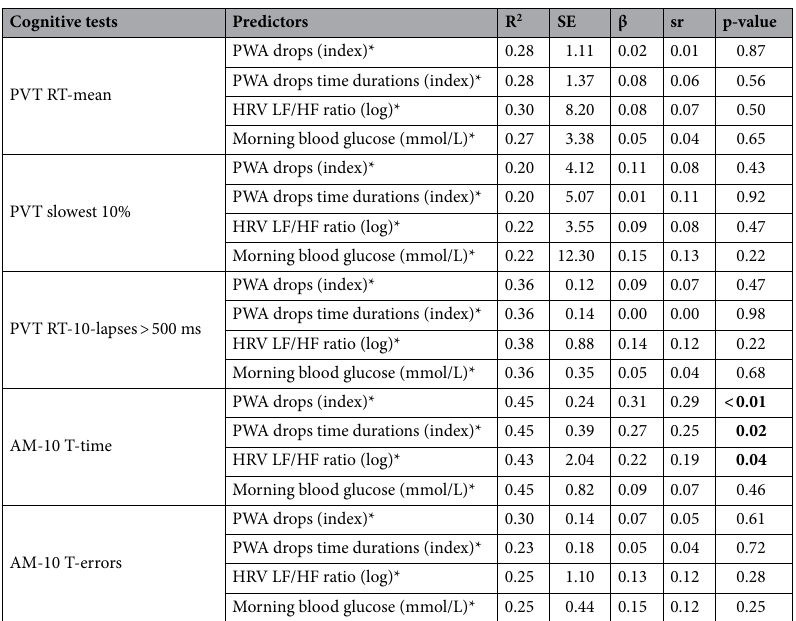
Table 5. Multiple linear regression analyses showing the association between the psychomotor vigilance test and Austin Maze and the sympathetic nervous system activity indices. *Significant model (p < 0.05) after false discovery rate adjustment; The model was adjusted for demographic cofounders, hypoxia, sleep fragmentation and depressive symptoms; R 2 the models’ multiple correlations, SE standard error, β standardized regression coefficient, sr semi-partial correlation, log logarithmic transformation, PVT psychomotor vigilance test, RT reaction time, AM Austin Maze, ms milliseconds, PWA pulse wave amplitude, HRV heart rate variability, LF low frequency, HF high frequency, mins minutes. Bolded p-values indicate statistically significant